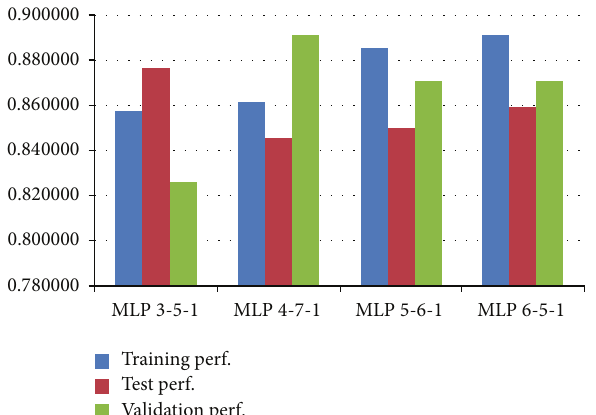
Figure 11: Performance of data training, data test, and data valida- tion in three, four, five, and six input